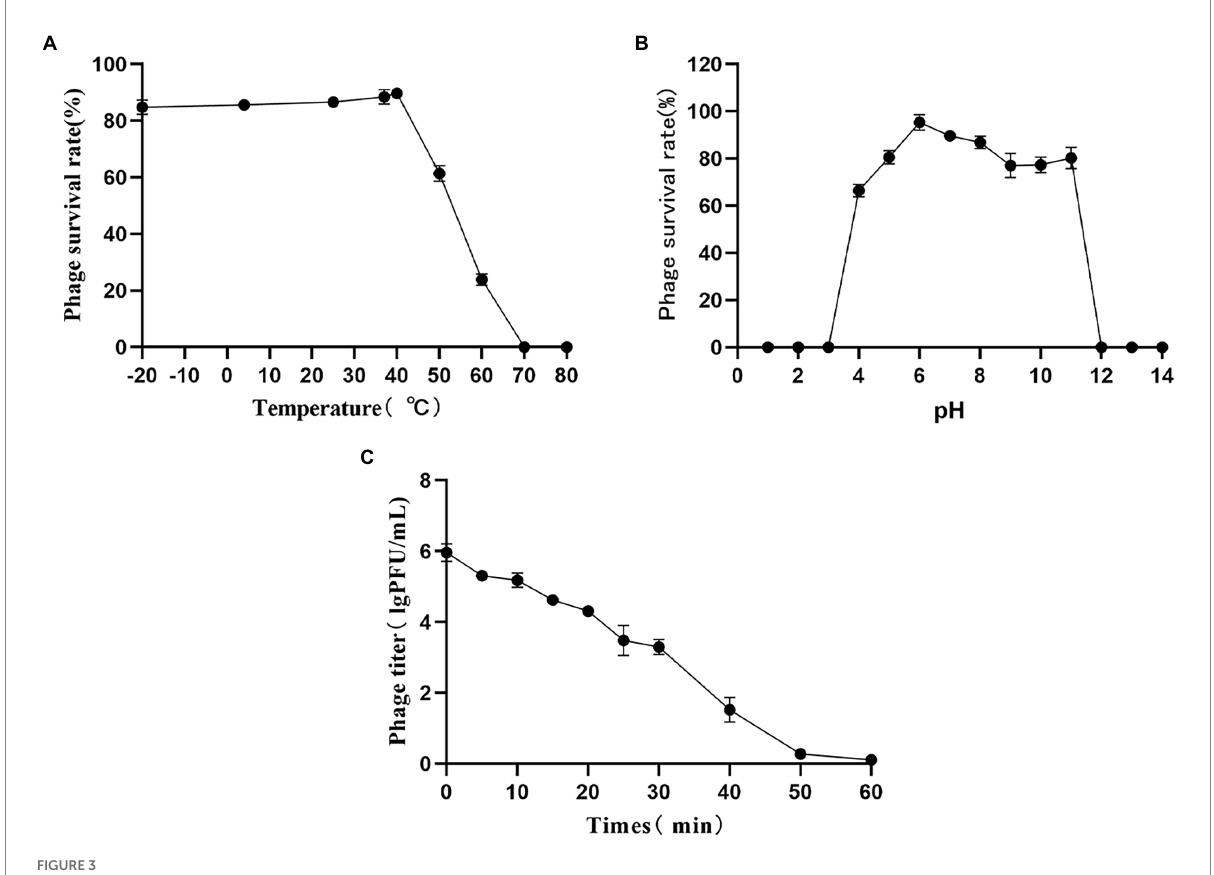
FIGURE 3 Temperature (A) , pH (B) , and UV (C) stability of phage PaVOA.